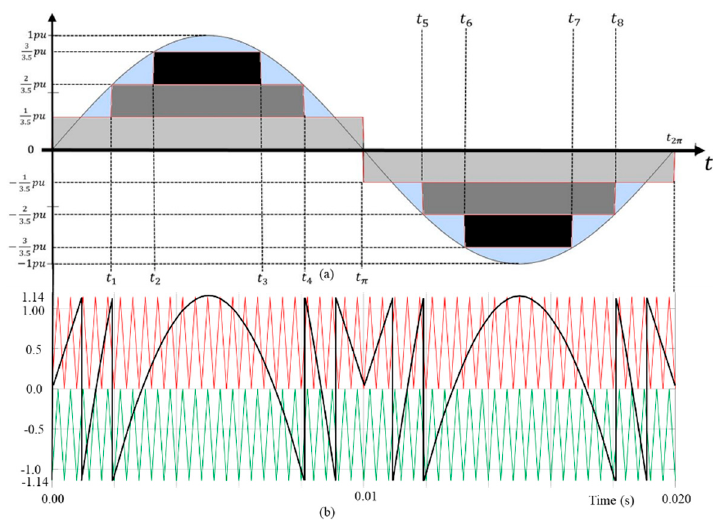
Figure 7. ( a ) The hybrid modulation technique and ( b ) differentiated gate signals with carrier signals.